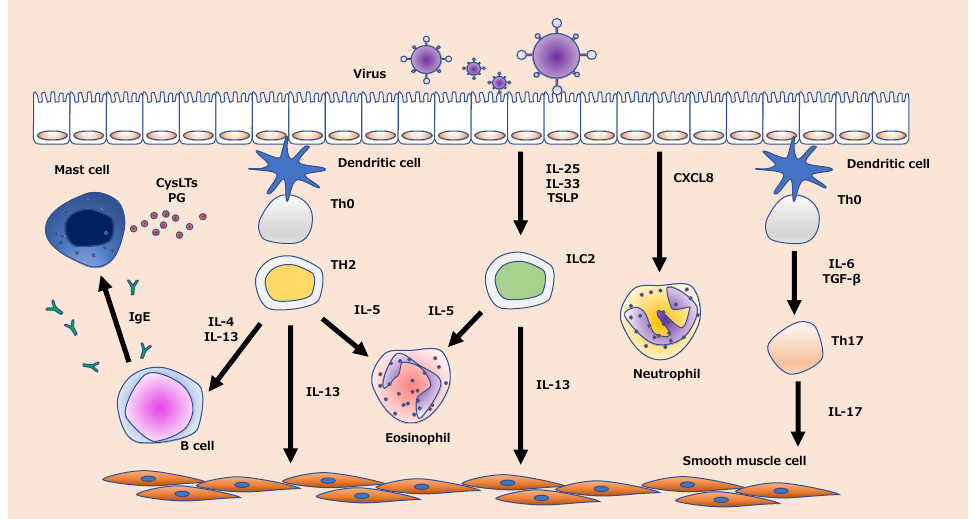
Figure 1. Immunological mechanism of virus-induced asthma exacerbations. When a virus infects the airway epithelium, airway inflammation is induced by multiple pathways. There are two types of airway inflammation: Type 2 airway inflammation involving IL-4, IL-5, IL-13, IgE, and ILC2, and non-Type 2 airway inflammation involving CXCL8 and Th17. CysLTs: cysteinyl leukotrienes. IL: interleukin; ILC2: group 2 innate lymphoid cell; PG: prostaglandin; TBG- β : transforming growth factor- β ; TSLP: thymic stromal